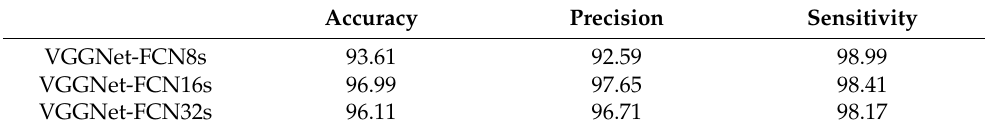
Table 2. The performance results (%) of VGGNet-FCN-based